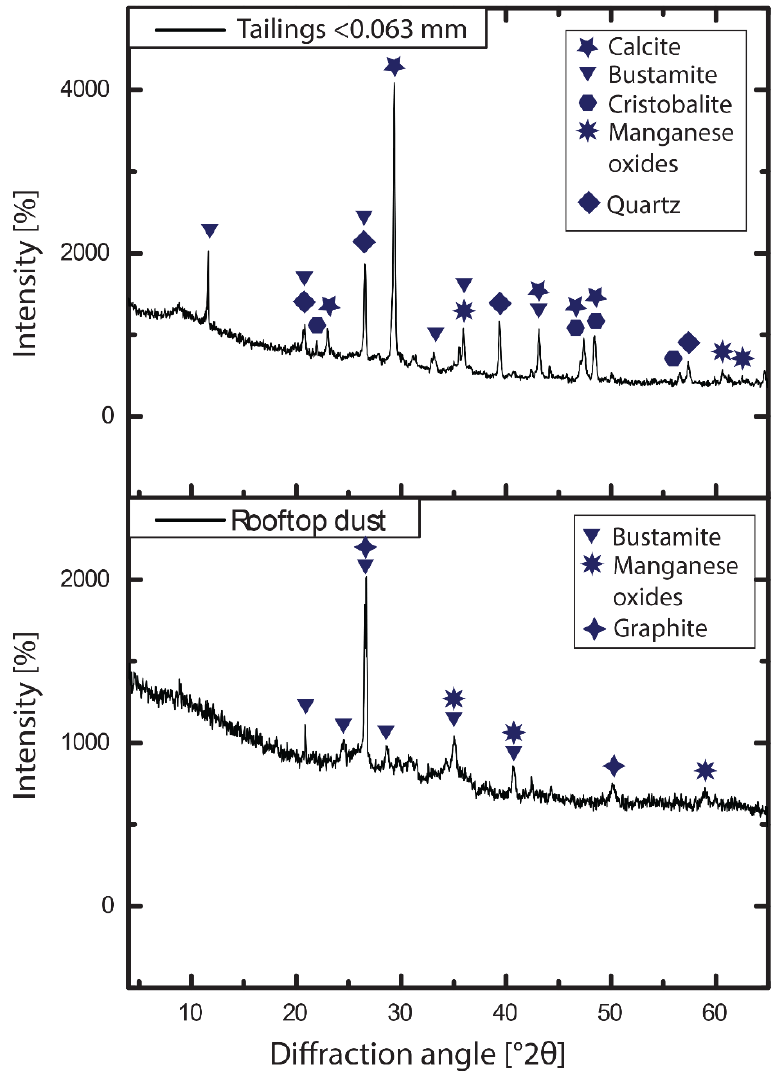
Figure 3. XRD data for tailings and dust